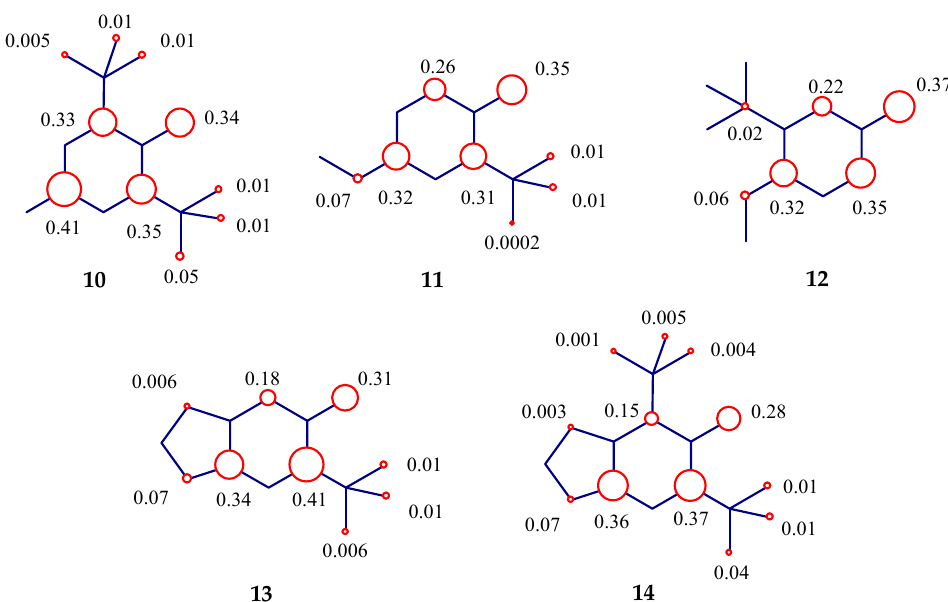
Figure 3. Spin density contributions of sesamol, related alkylated derivatives, and classical antioxidants by B3LYP/6-31+G(d,p). The explored spin density values were calculated by considering the hydrogen uptake from the phenolic hydroxyl group and carbons from the benzene portion.